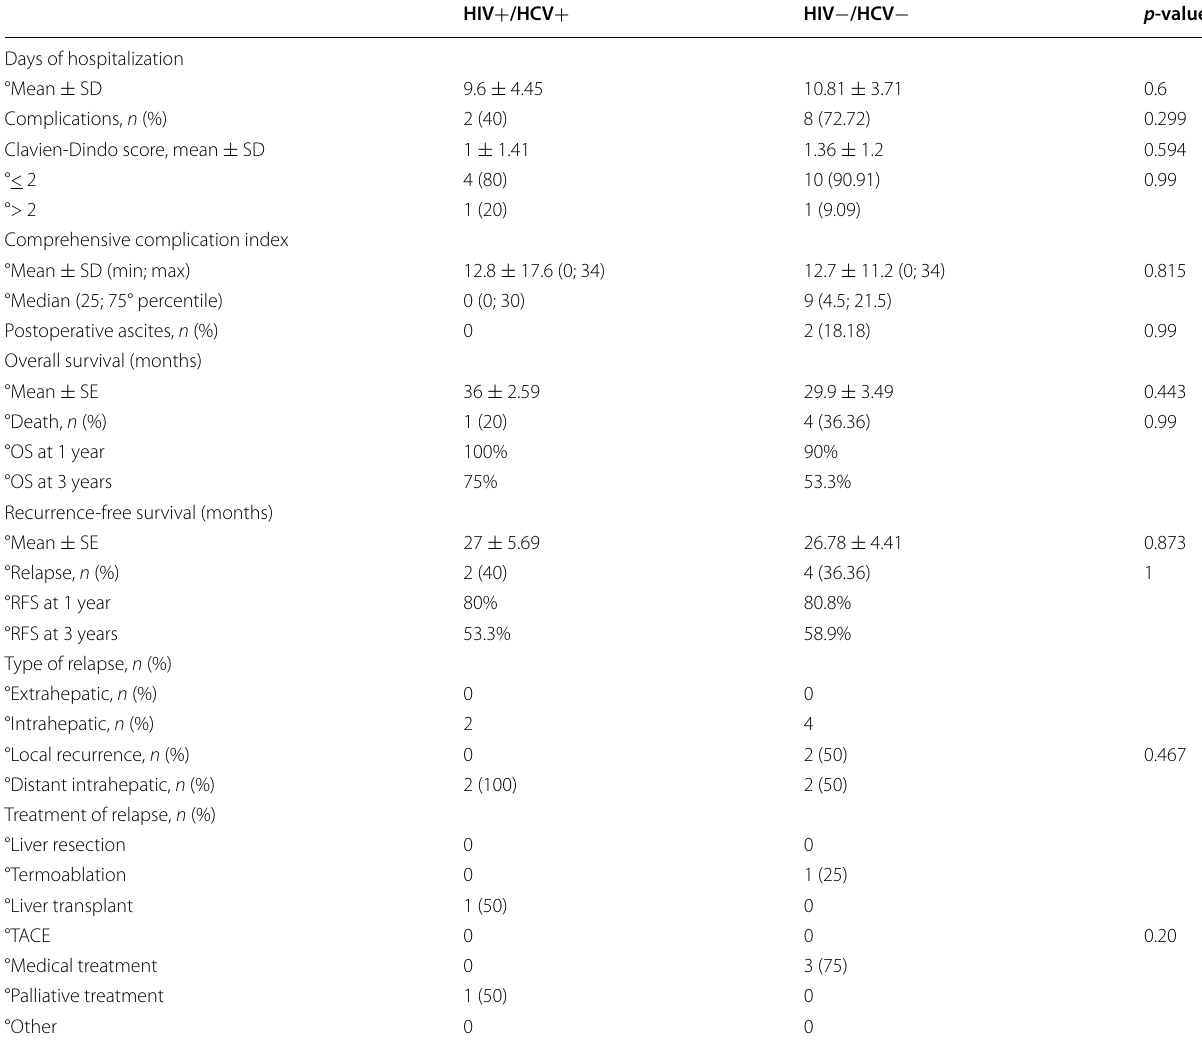
Table 4 Outcomes and survival